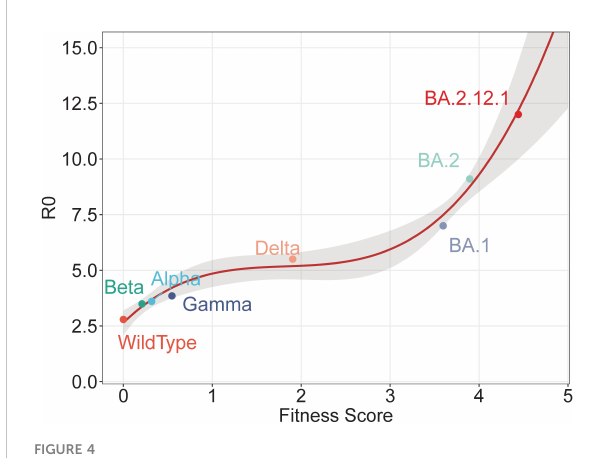
FIGURE 4 Polynomial regression of fi tness score and R0. The regression is trained by all points except BA.2.12.1, with the shaded area representing the 75% con fi dence interval. The point of BA.2.12.1 is subsequently illustrated as a validation.